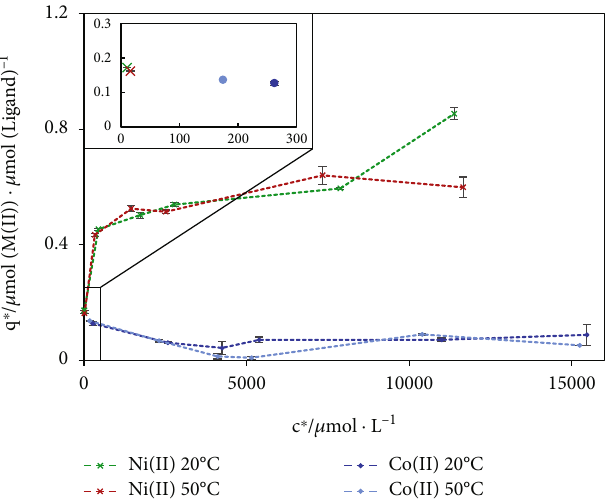
Figure 2: Adsorption isotherms of the equimolar dual-component system Ni(II) :Co(II) at T = 20 ° C, and 50 ° C, respectively. The zoomed ð M ð II ÞÞ = 1000 μ mol · L − 1 ). area depicts the isotherm at low concentrations ( c 0 Table 5: Correlation between proton release per adsorbed metal ion during adsorption, stability constant K loading q ∗ at T = 20 ° C in di ff erent competitive adsorption experiments at Ni(II) :Co(II) molar ratio of 1:1.